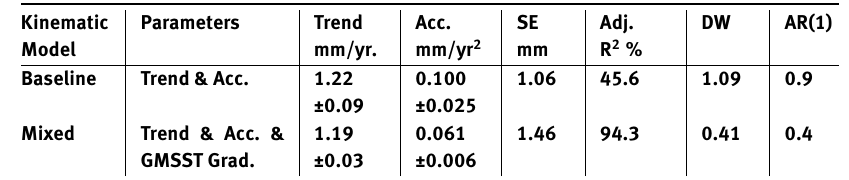
Table 2. H-L solution statistics for the baseline and mixed kinematic models. All the estimated parameters are statistically significant at alpha = 0.05.